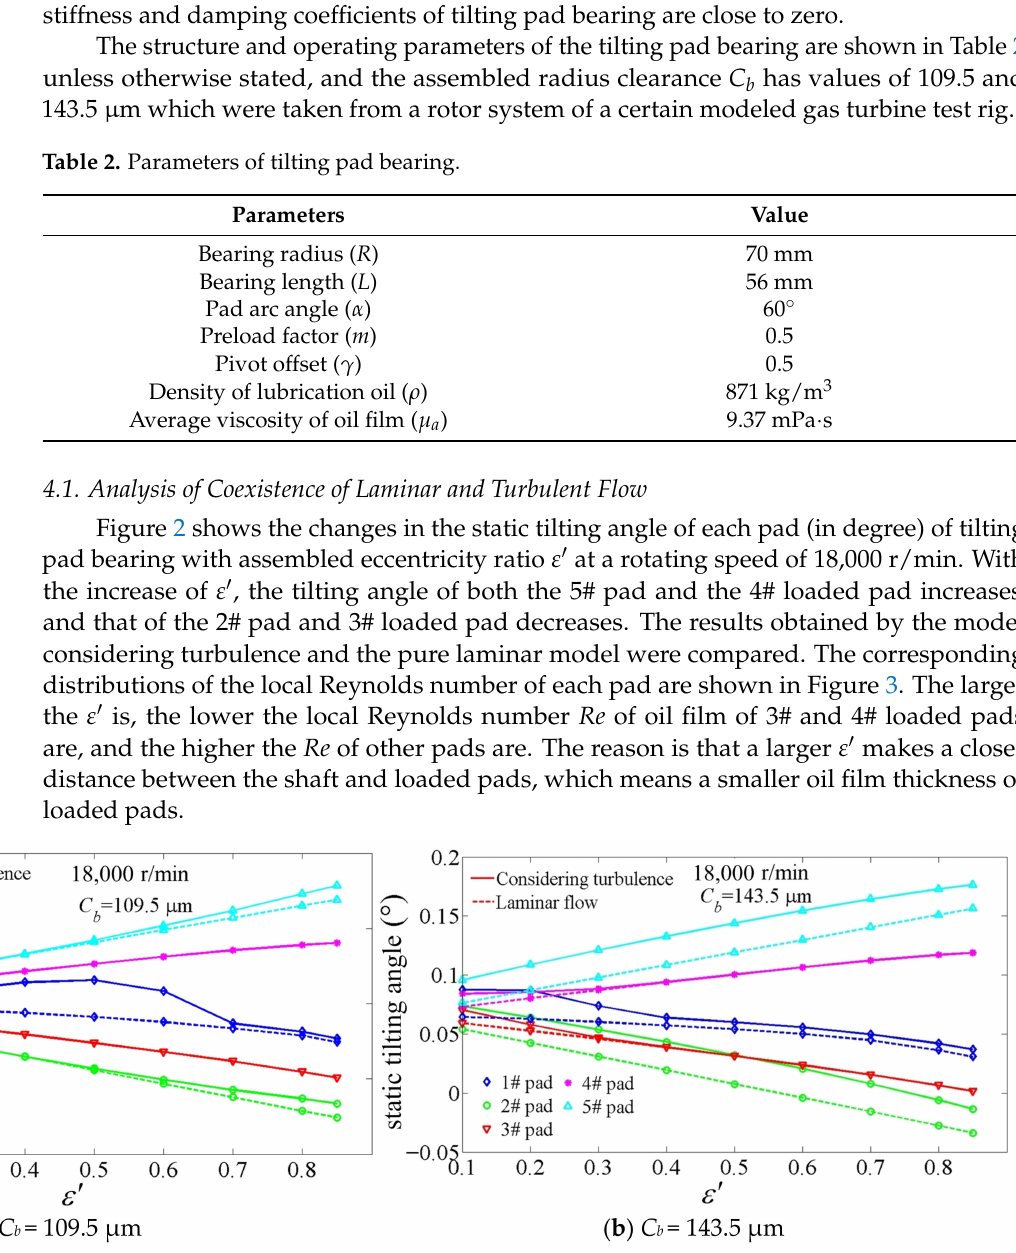
Figure 2. Changes of the static tilting angle of each pad of tilting pad bearing with assembled eccentricity ratio at different assembled